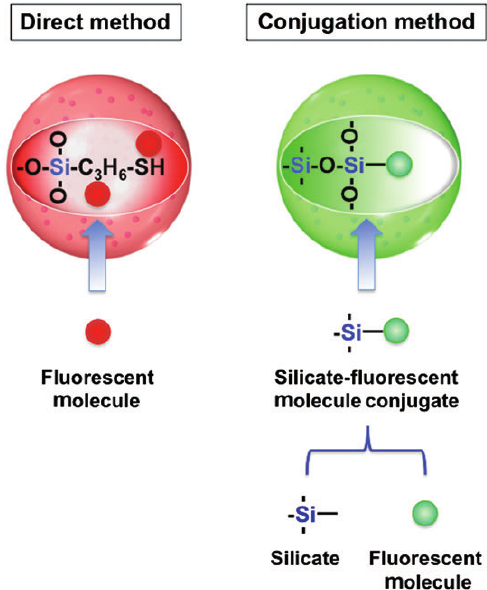
Figure 2 Preparation scheme of fl uorescent organosilica nanopar- ticles using the direct method and the conjugation